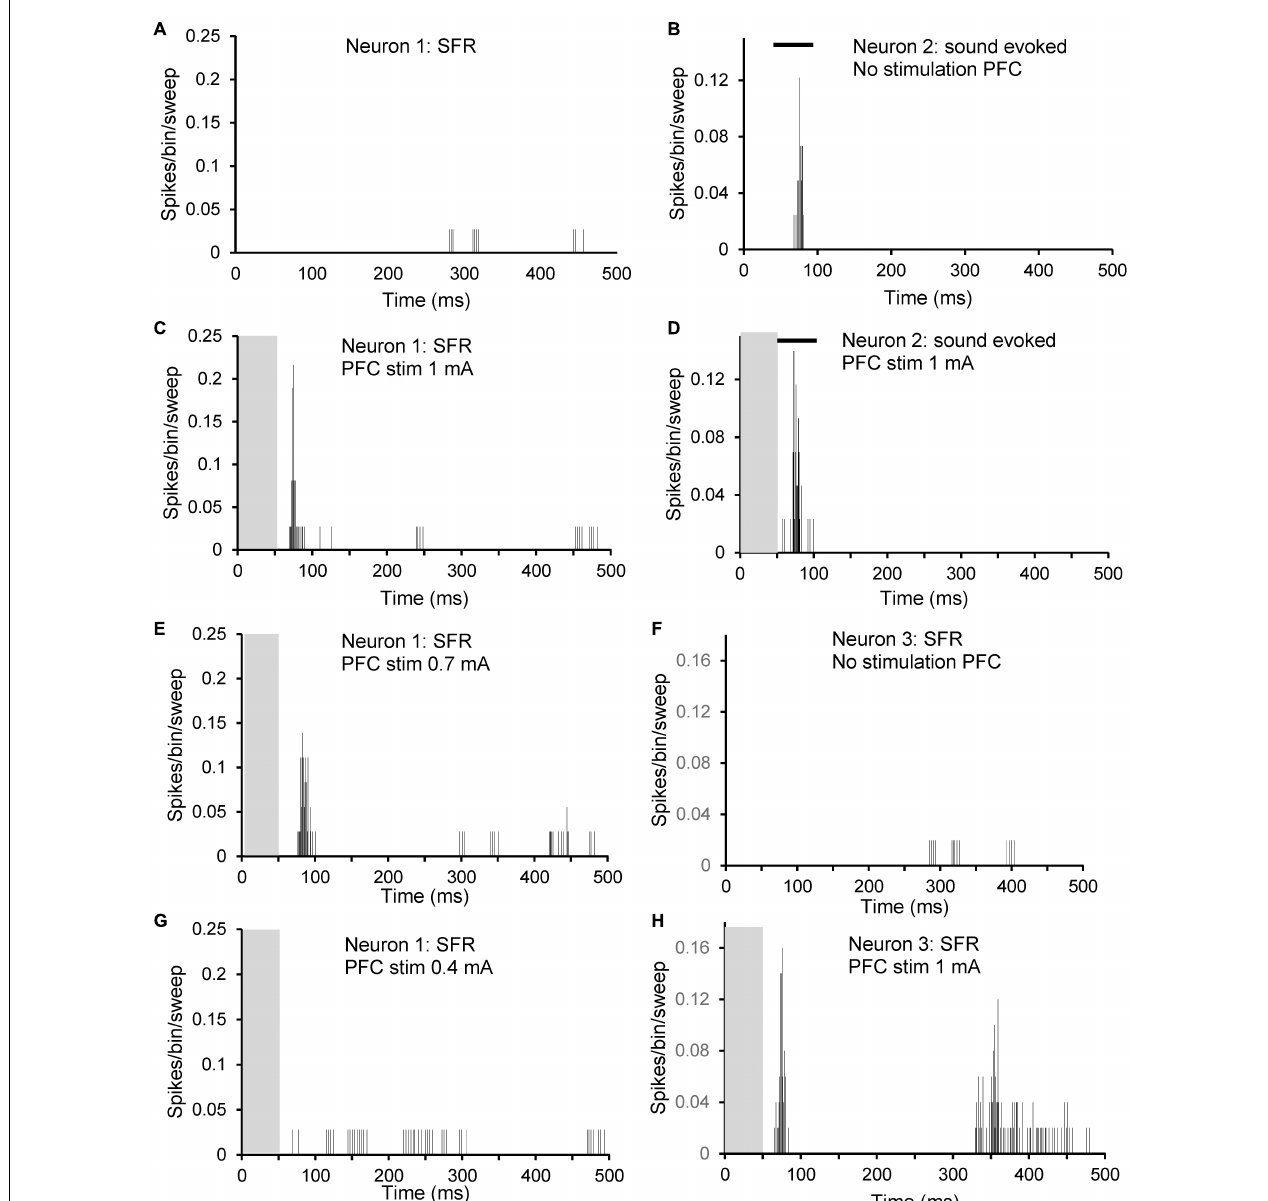
FIGURE 6 | Peristimulus time histograms (PSTHs) illustrating excitatory effects of PFC electrical stimulation at different stimulation strengths on three different neurons. Neuron 1: (A,C,E,G) : spontaneous firing of a neuron with CF 1.9 kHz, threshold at 86 dB SPL and with SFR 2.1 spikes/sec. (A) No stimulation; (C) 1 mA; (E) 0.7 mA; and (G) 0.4 mA. Neuron 2: (B,D) : sound evoked firing at CF at 20 dB over threshold of a neuron with CF 8.9 kHz, threshold 86 dB SPL and with SFR of 0.2 spikes/sec. (B) No stimulation; (D) 1 mA. Neuron 3: (F,H) : spontaneous firing of a neuron with CF 4.7 kHz, threshold at 55 dB SPL and with SFR 0.4 spikes/sec. (F) No stimulation; (H) 1 mA. Note that neuron 1 showed no effect of electrical stimulation on sound evoked activity. Grey column indicates electrical stimulation and black bar in (B,D) illustrates timing of tone